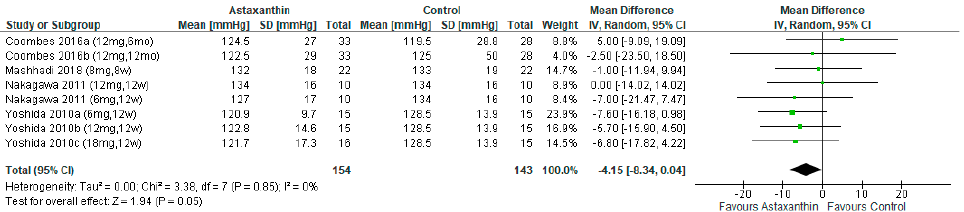
Figure 4. Forest plot of the effect of astaxanthin on systolic blood pressure [26–28,31]. Bold means total data.